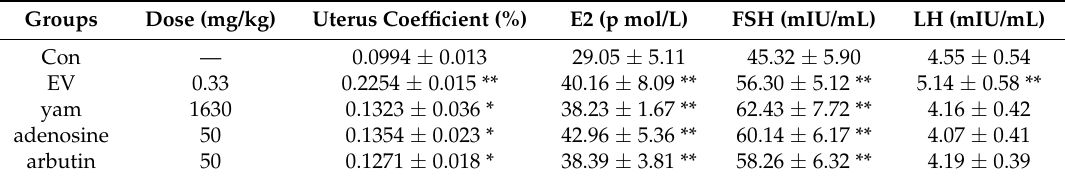
Table 4. Effect on uterus coefficient, E2, FSH and LH (x ± SD, n =